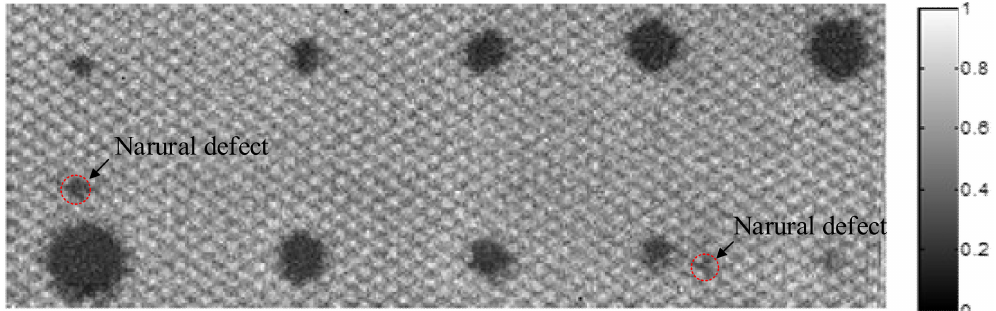
Figure 12 The C-scan result of honeycomb sandwich composite. Figure 12. The C-scan result of honeycomb sandwich